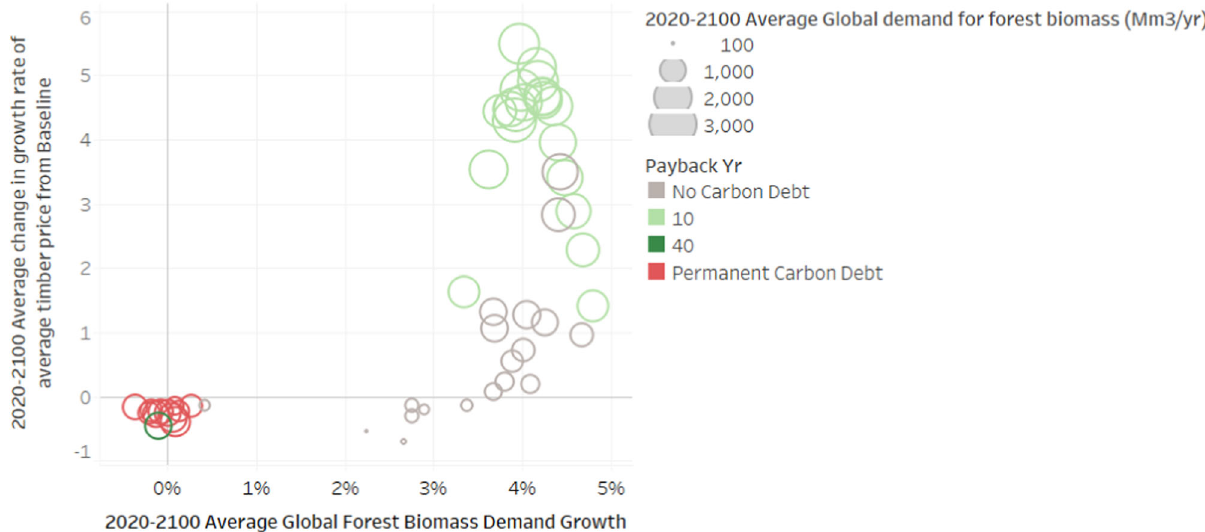
Fig. 4 Payback period of forest carbon debt under 51 demand scenarios divided by annual average forest biomass demand growth rate and change in average timber price growth from baseline, 2020 – 2100 (market C excluded). Each circle shows the payback period of the forest carbon debt per scenario according to the annual average forest biomass demand growth rate ( x -axis) and change in average timber price growth from baseline ( y -axis). All carbon pools with the exception of market carbon are included in the carbon debt calculation. The color of the circle identi fi es the payback period: scenarios that never recover the carbon debt are in red (permanent carbon debt), scenarios that recover it between 20 and 40 years are in green while scenarios that do not experience the carbon debt are in gray. The size of the circle represents the global annual average biomass quantity supplied between 2020 and 2100 and it ranges from 100 to 3000 Mm 3 /yr.